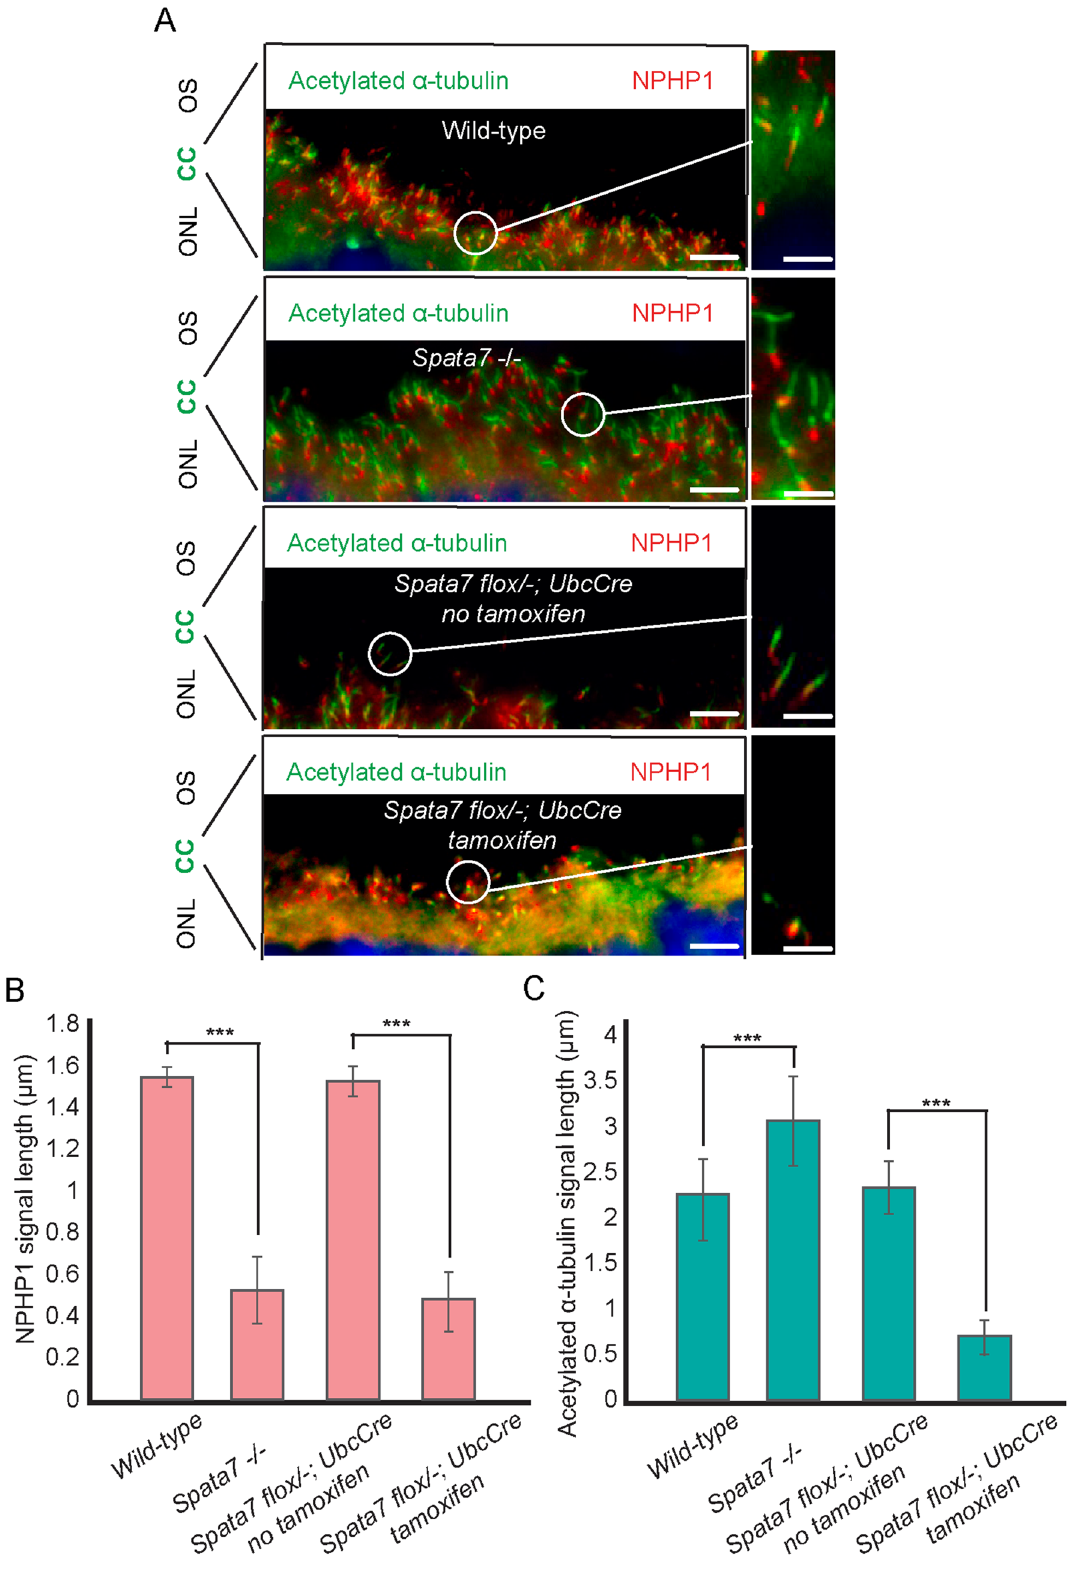
Figure 4. Conditional loss of Spata7 in adult mouse retinas leads to collapse of the distal region of the CC. ( A ) Retinal cryosections of 6-month-old Spata7 flox/− ; UbcCreERT2 mice with or without tamoxifen induction and 3-month-old wildtype and Spata7 −/− mice were costained for NPHP1 (red) and acetylated α-tubulin (green). A single-cilium image of NPHP1 localized to the distal CC is shown on the right. Bars for single-cilium images are 1 µm. ( B and C ) Histogram displaying NPHP1 ( B ) and acetylated α-tubulin ( C ) signal length from 6-month-old Spata7 flox/− ; UbcCreERT2 mice with or without tamoxifen induction and 3-month-old wild-type and Spata7 −/− mice. Statistical analysis was performed using two-way ANOVA analysis (*** p < 0.001). N = 5 mice per genotype, 10 CC per